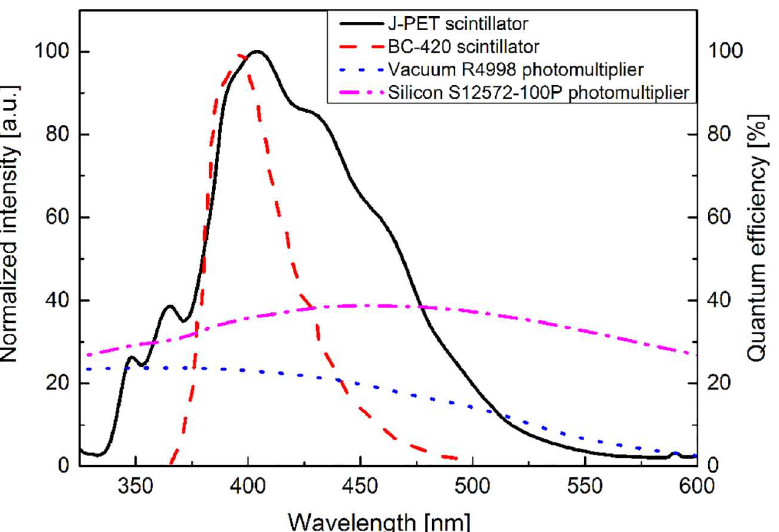
Fig 5. Emission spectraof scintillators and quantum efficieny of photomultipliers. Emission spectra of the J-PET (solid line) and BC-420 (dashedline) scintillators [22] superimposed on the quantumefficiency dependence on photonswavelengthfor typical vacuum tube photomultiplier with bialcaliwindow(dotted line) [35] and silicon photomultipliers (dashed-dotted line) [35]. Maximum of emissionfor BC-420scintillator is placedat wavelengthof 393 nm while the maximum of the J-PET scintillatorat 403 nm. The emissionspectra are normalized in amplitude.